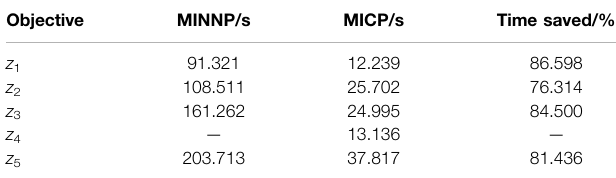
TABLE 2 | Comparison of CPU time of the MINNP and MICP models.